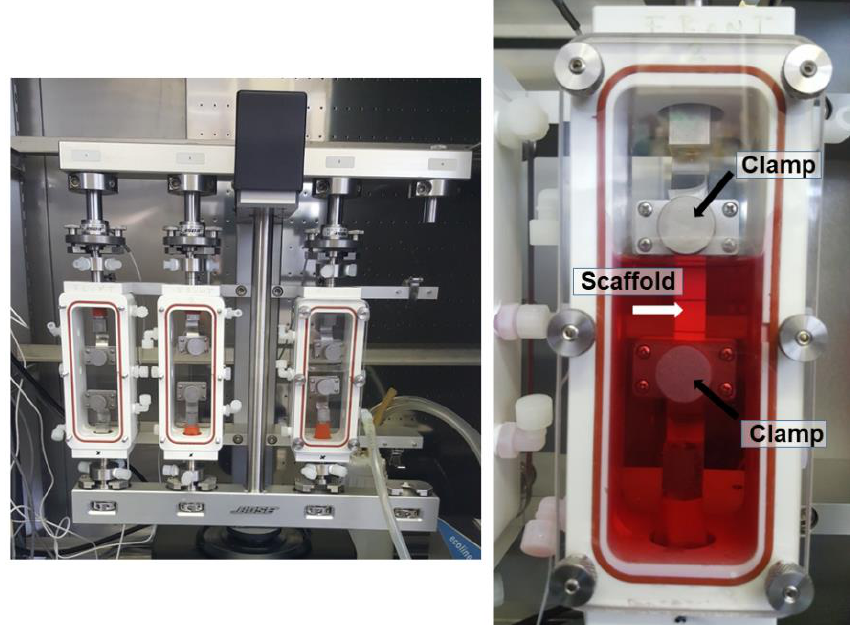
Figure 1. Bose ® bioreactor system, with three chambers. Within the chamber, there are two self-made clamps (black arrows) to grip the scaffold material (white arrow). A scaffold attached to the two grips is shown and the chamber is filled with DMEM culture medium (red fluid).